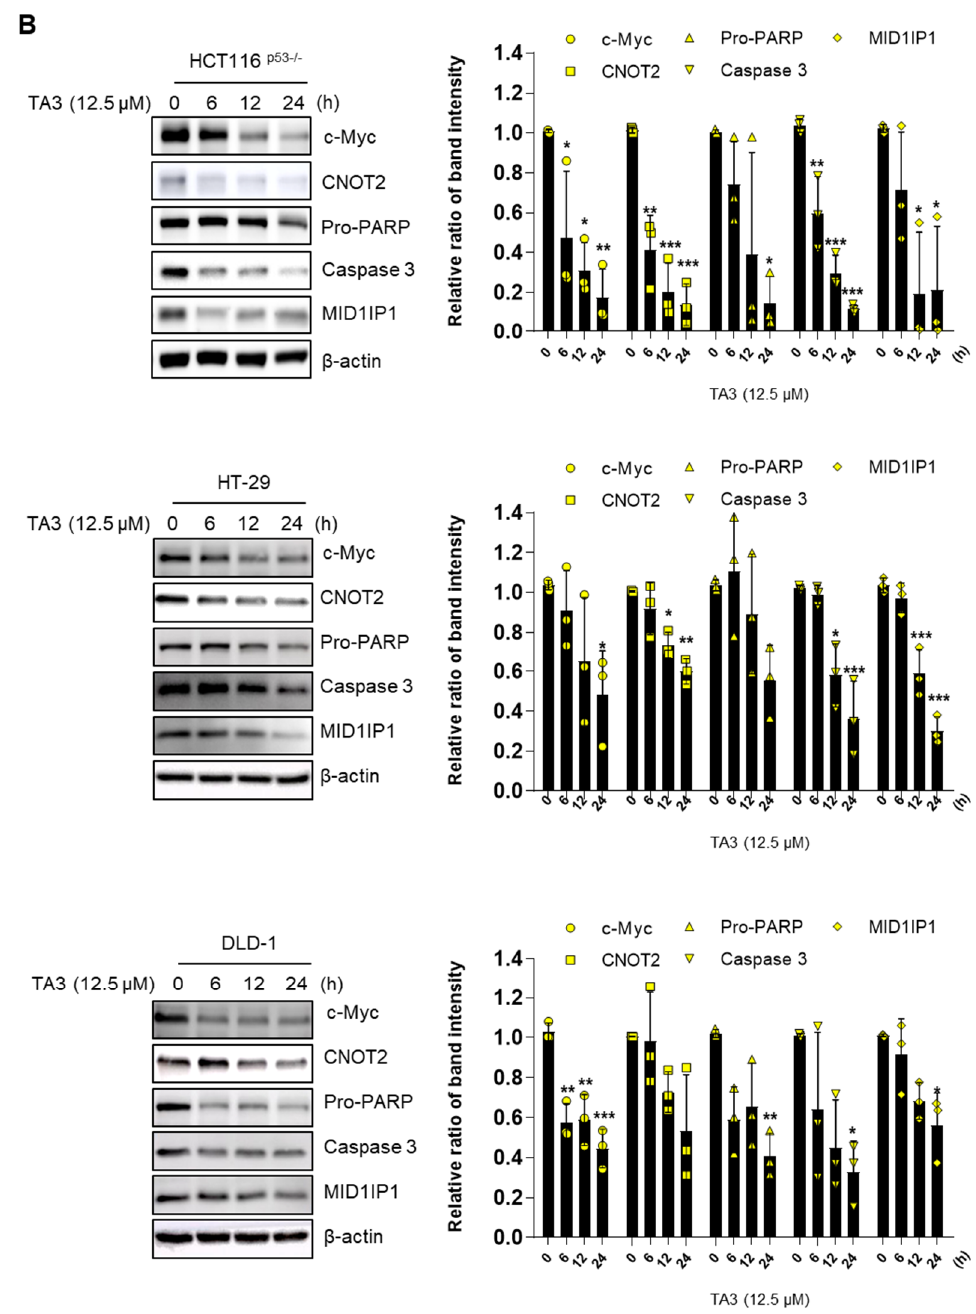
Figure 2. TA3 attenuated the expression of c-Myc in colorectal cancer cells. ( A ) Cells were treated with TA3 (0, 7.5, 10, and 12.5 μM) for 24 h. ( B ) Cells were treated with TA3 (12.5 μM) at various time points for Western blotting (three independent experiments in each cell). Statistical significance was analyzed using one-way analysis of variance (ANOVA) followed by Tukey’s test. p -values indicate a significant difference between the groups. Quantification of protein expression is shown in the right panel. * p < 0.01, ** p < 0.005, *** p < 0.001 vs. control.